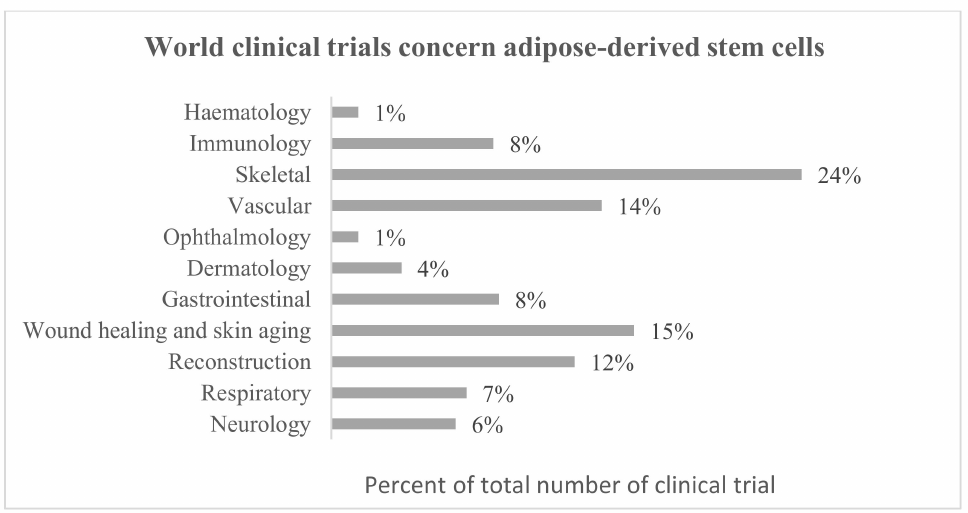
Figure 4. Summary of World clinical trials concern adipose-derived stem cells based on all clinical trials available in the database (years 2007–2021)